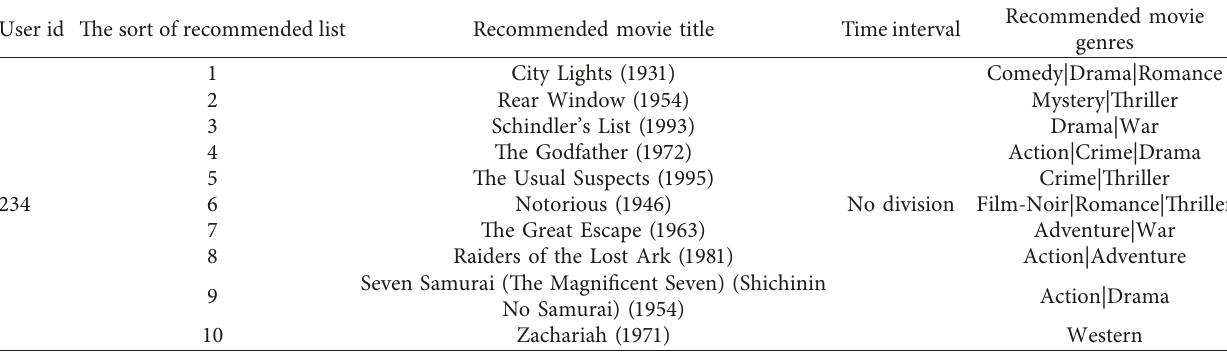
Table 4: The example of the recommended movie list of general CNN-based recommendation algorithm. User id The sort of recommended